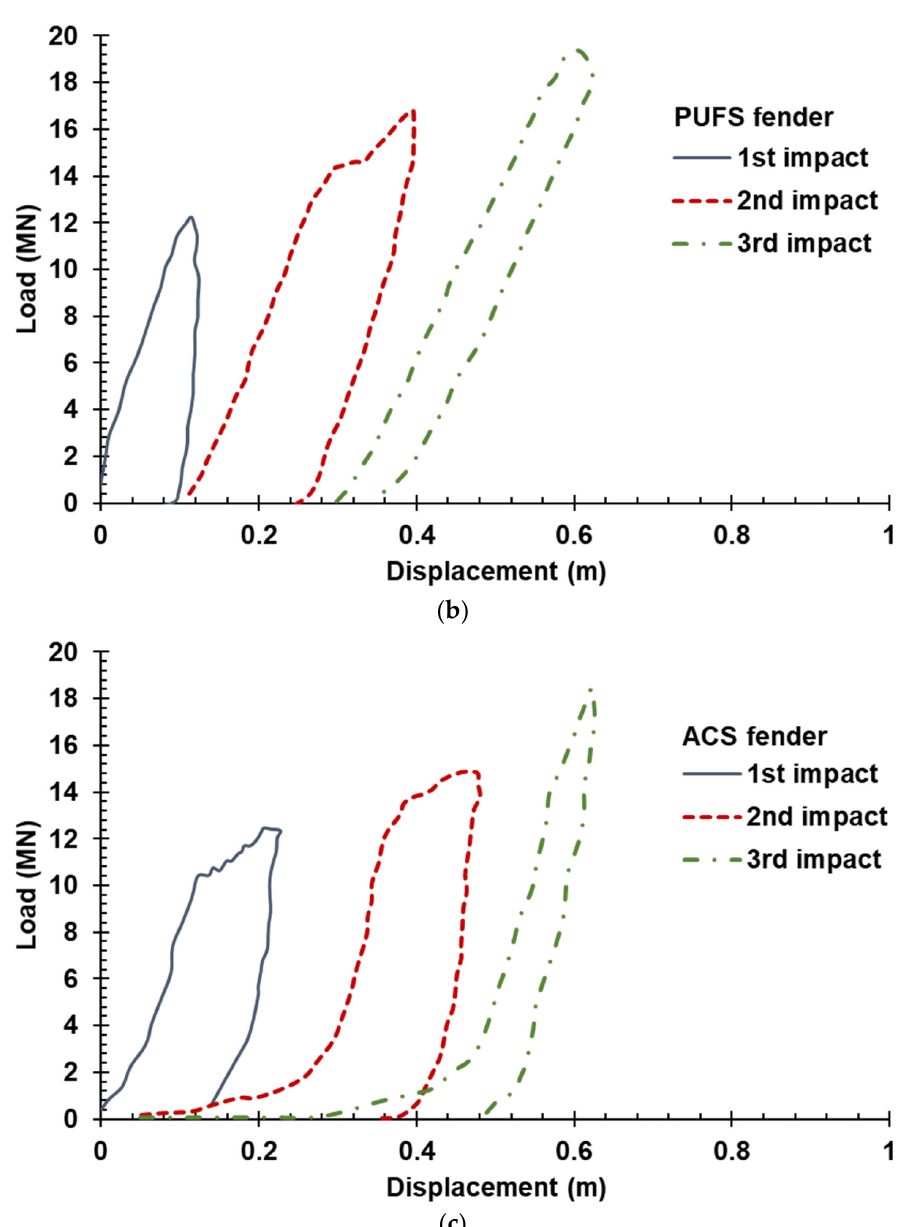
Figure 15. Multi-impact responses of the OWT-Ship impact scenario with different materials. ( a ) AFS fender; ( b ) PUFS fender; ( c ) ACS fender. fender; ( b ) PUFS fender; ( c ) ACS